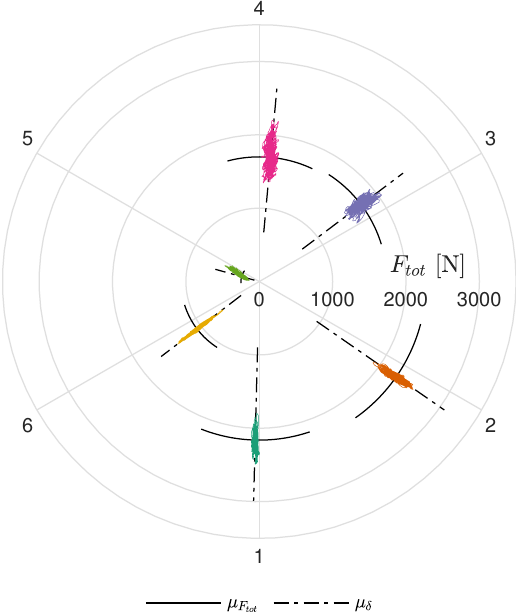
Figure 14: Plot showing forces F tot on panel 711 carrying strain rollers, together with the mean force µ F shown.